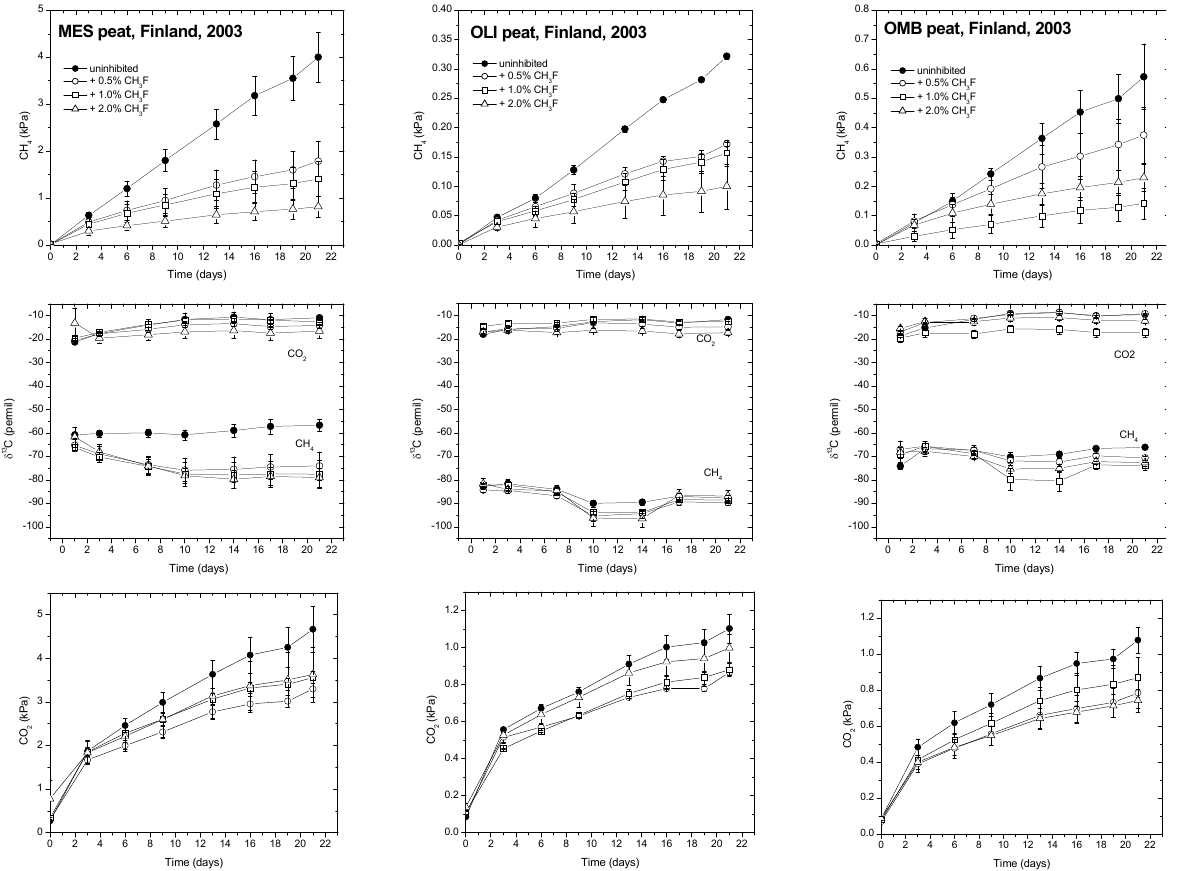
Fig. 1. Time course of accumulation of CH 4 and CO 2 , and of δ 13 C of the accumulated CH 4 and CO 2 in the absence and presence of different concetrations of CH 3 F, an inhibitor of acetoclastic methanogenesis (CH 3 F) using samples from three different peatland ecosystems in Finland, i.e., mesotrophic fen (MES), oligotrophic fen (OLI), and ombrotrophic bog (OMB); mean ± SE, n =